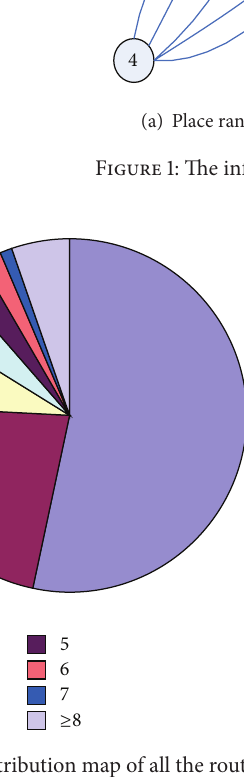
Figure 2: The degree distribution map of all the routers in China. Here we use the traversal algorithm. Traverse every position of the matrix when it is put in pellet 𝑖 and find the position where the force is the minimum; it is also the balance and final position of pellet 𝑖 .